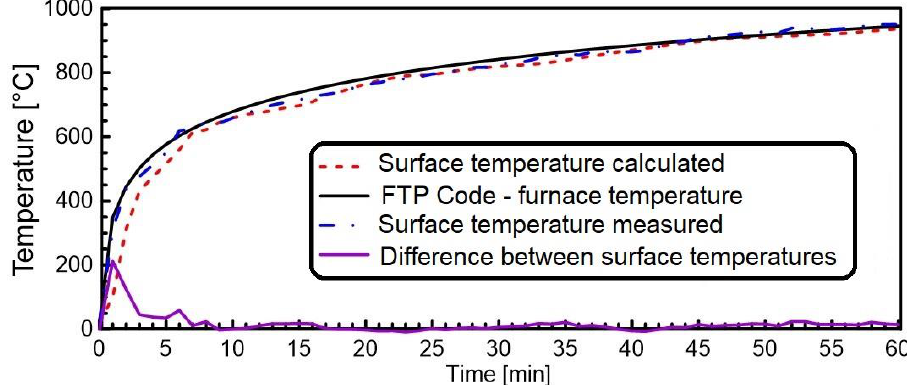
Figure 4. Temperature profiles on the door fire-exposed side. Delta: difference between measured and modeled surface temperatures.